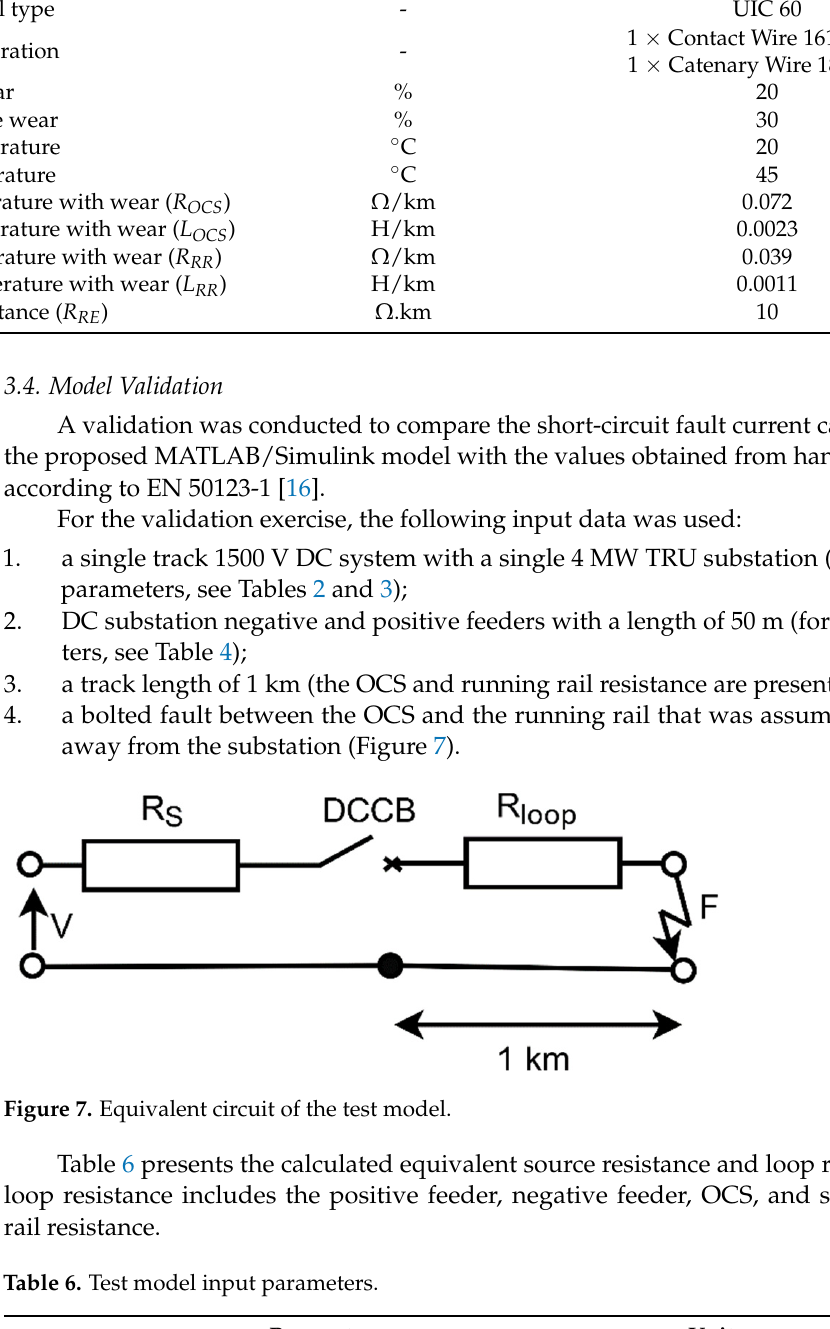
Table 6. Test model input parameters.